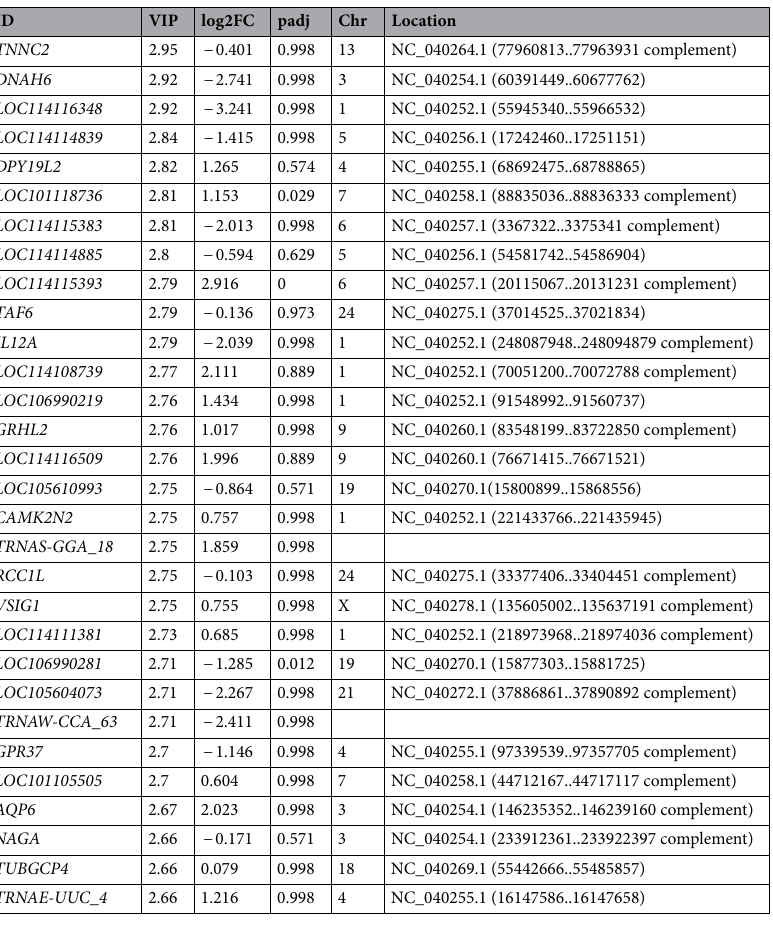
Table 5. Top 30 potential coding biomarkers in female fetal LV exposed to excess T. Top 30 coding RNA biomarkers comparing control female and T-treated female fetal LV tissue based on variable importance in Projection values. (M2.VIP[3]) along with the corresponding log2FC and padj values obtained from DESeq2 analysis for the same determinants are represented. ncRNA is highlighted in